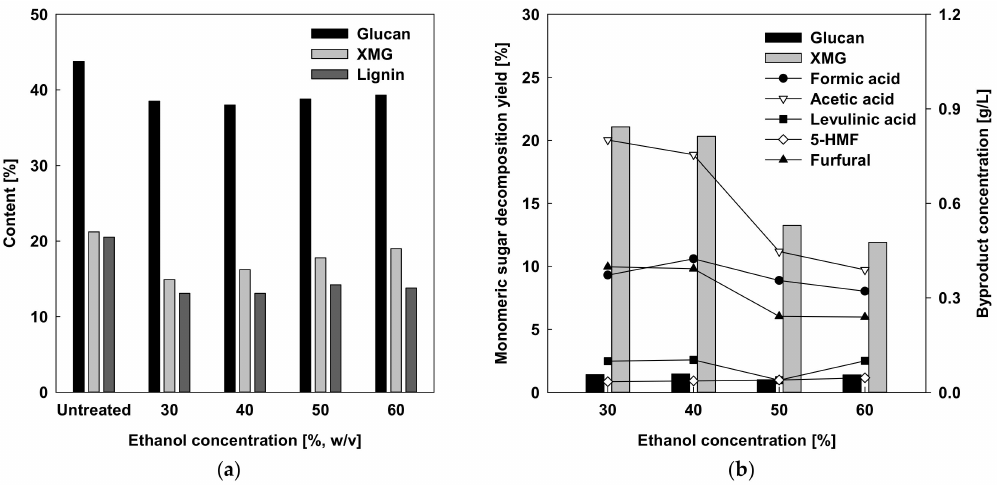
Figure 1. Effect of ethanol concentration on ( a ) solid content of untreated and pretreated Miscanthus × giganteus (MG); ( b ) monomeric sugar and byproduct concentrations of liquid hydrolysate. Reaction conditions: 170 ◦ C, 60 min, liquid/solid (L/S) ratio = 10. Data in the figure are based on untreated biomass